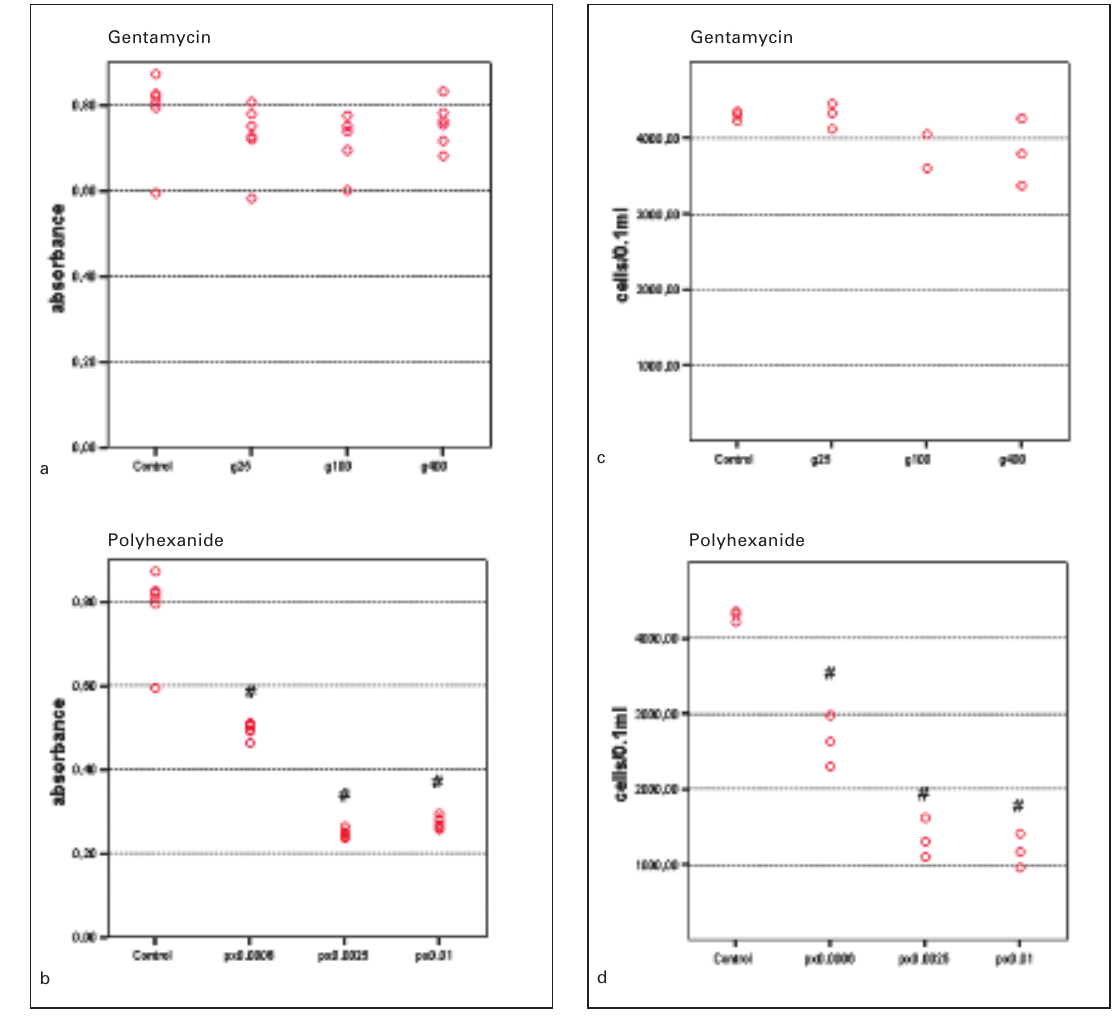
Figure 3 Effect of a) gentam- icin and b) polyhexa- nide on human endothelial cell viability. Effect of c) gentamicin and d) polyhexanide on human endothelial cell number. (g = gentamicin, px = polyhexanide, # p <0.05 versus